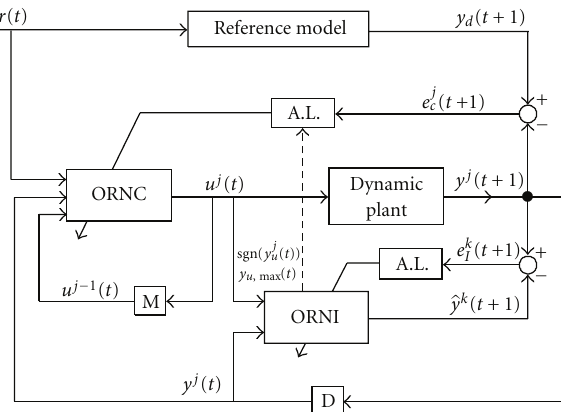
Figure 2: Block diagram of the ORNN-based ILC